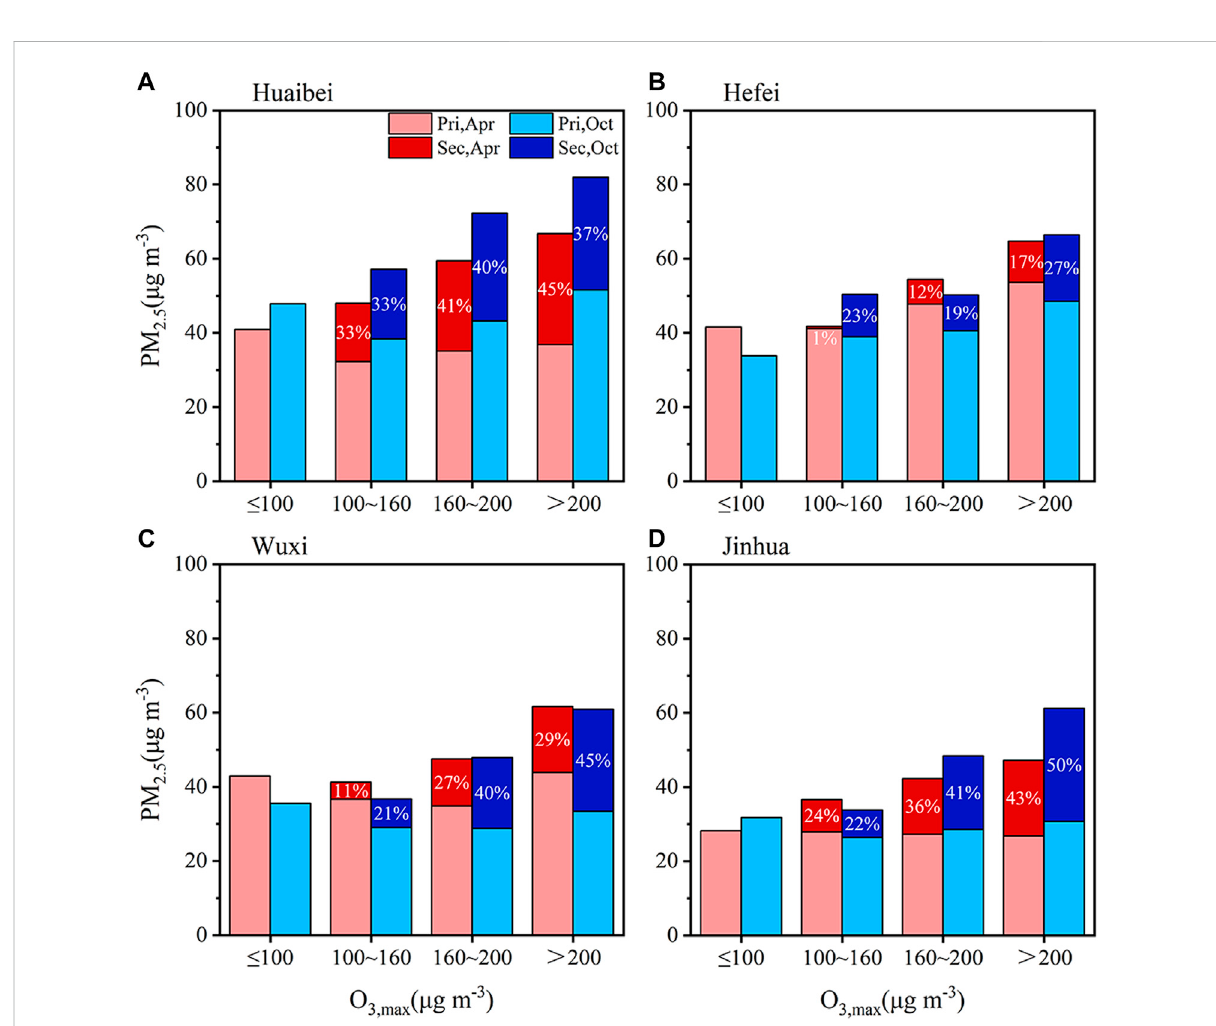
FIGURE 7 Proportions of secondary components in ambient PM 2.5 (primary plus secondary) under different photochemical activities in (A) Huaibei, (B) Hefei, (C) Wuxi, and (D) Jinhua cities in April and October from 2015 through